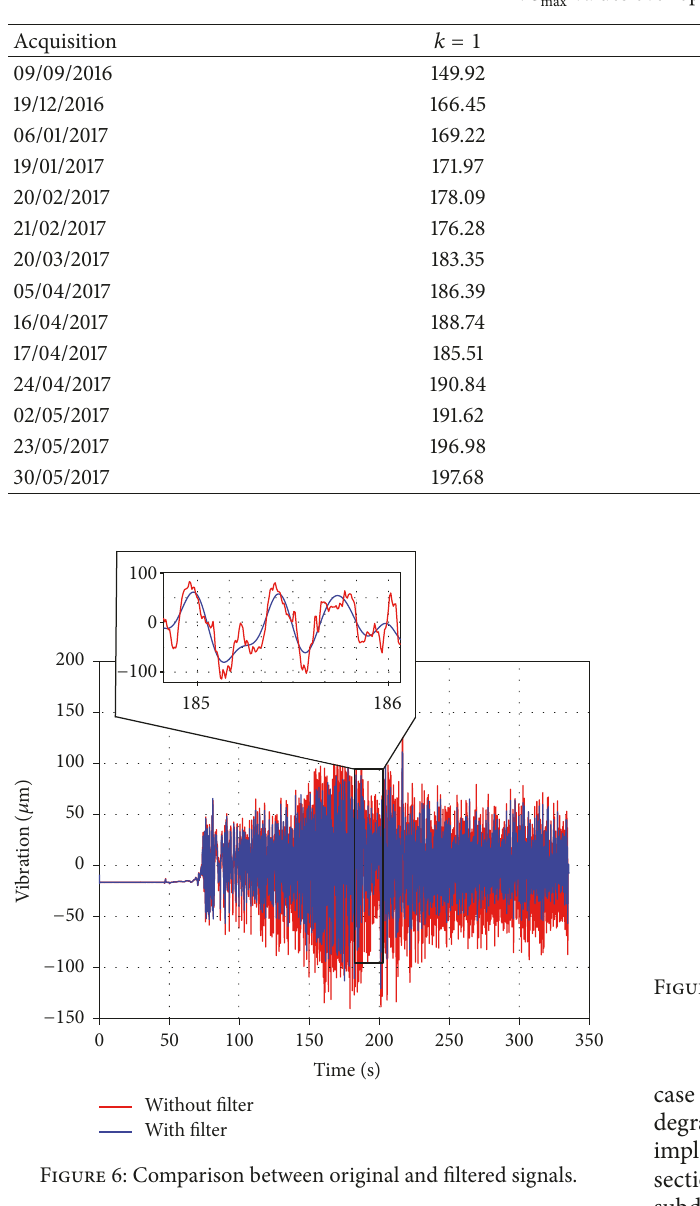
Table 4: 𝑆 max values over operation time.